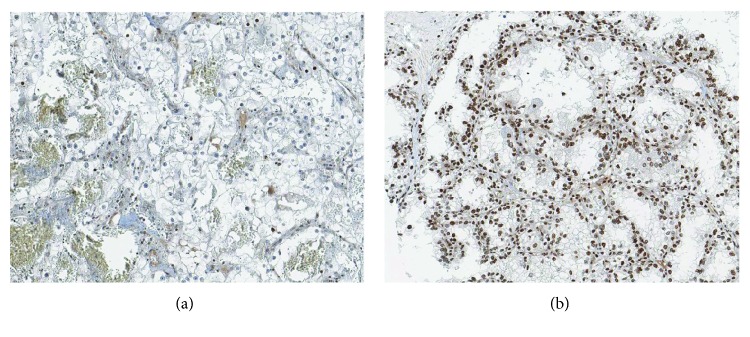
Immunohistochemical expression of CASZ1 in clear cell renal cell carcinoma. Representative images of low (a) and high (b) expressions (×200).